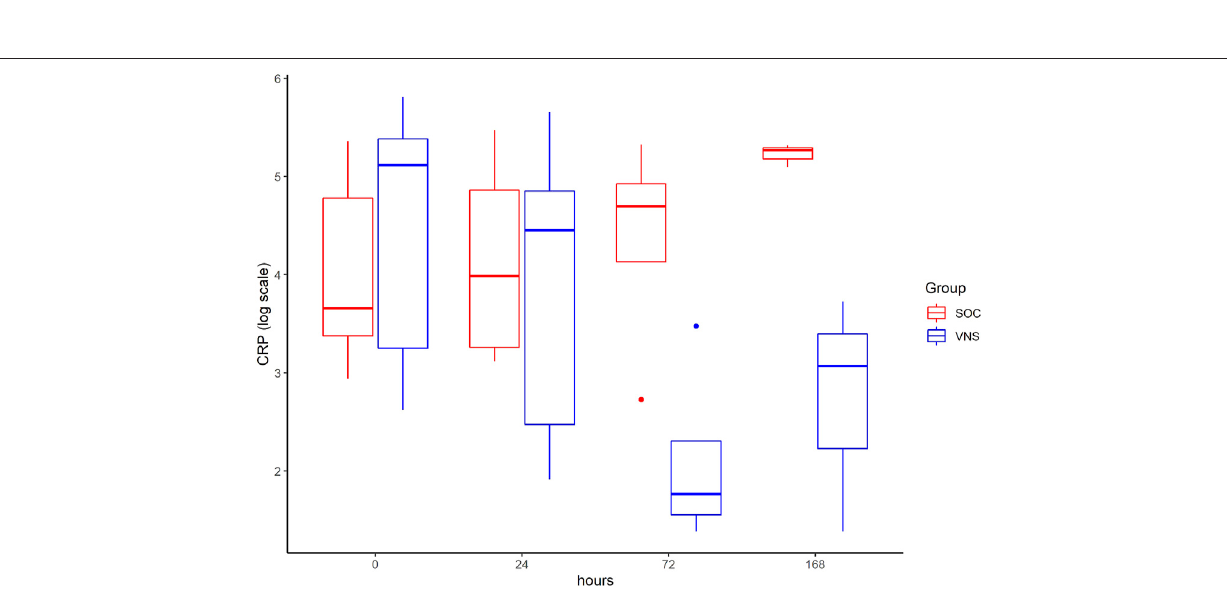
Frontiers in Physiology |